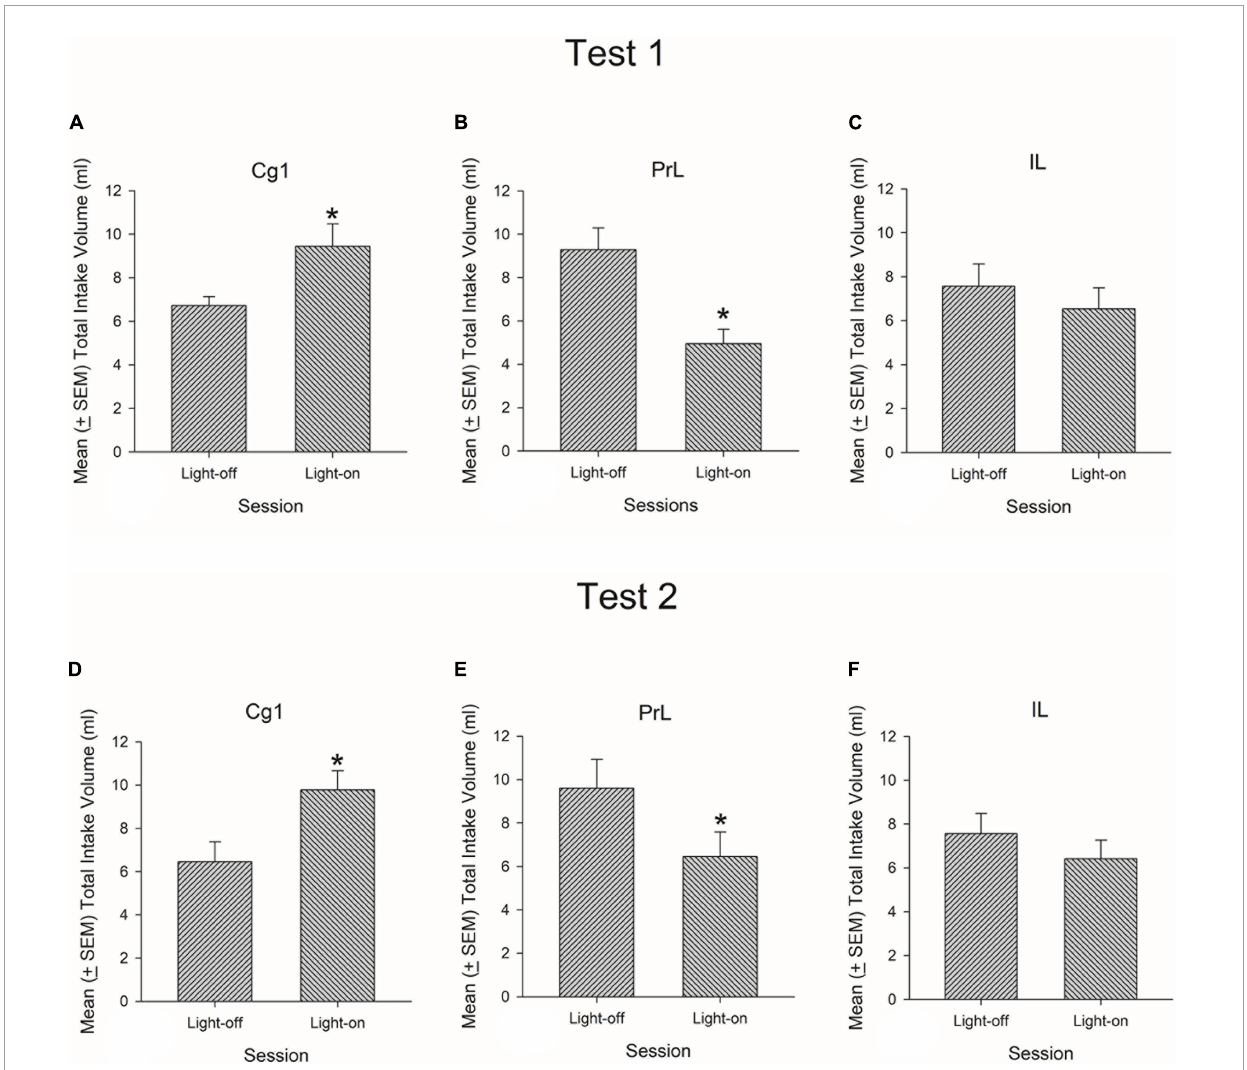
FIGURE2 Mean ( ± SEM) total intake volume of saccharin solution in rats with exposure to 3-min light-on and 3-min light-off optical stimulation twice over each 12 min session in the Cg1, PrL, and IL in Tests 1 (A–C) and 2 (D–F) . * p < 0.05 indicates a significant difference between the light-on and light-off